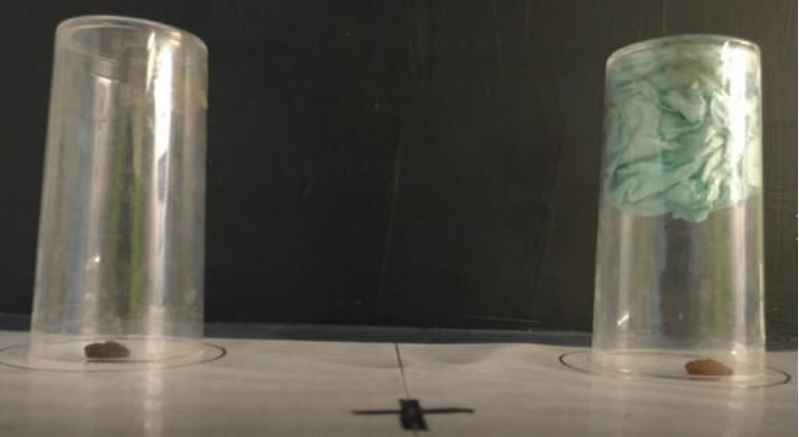
Photo of the Blocked Cups Set-Up for the Non-Functional Condition